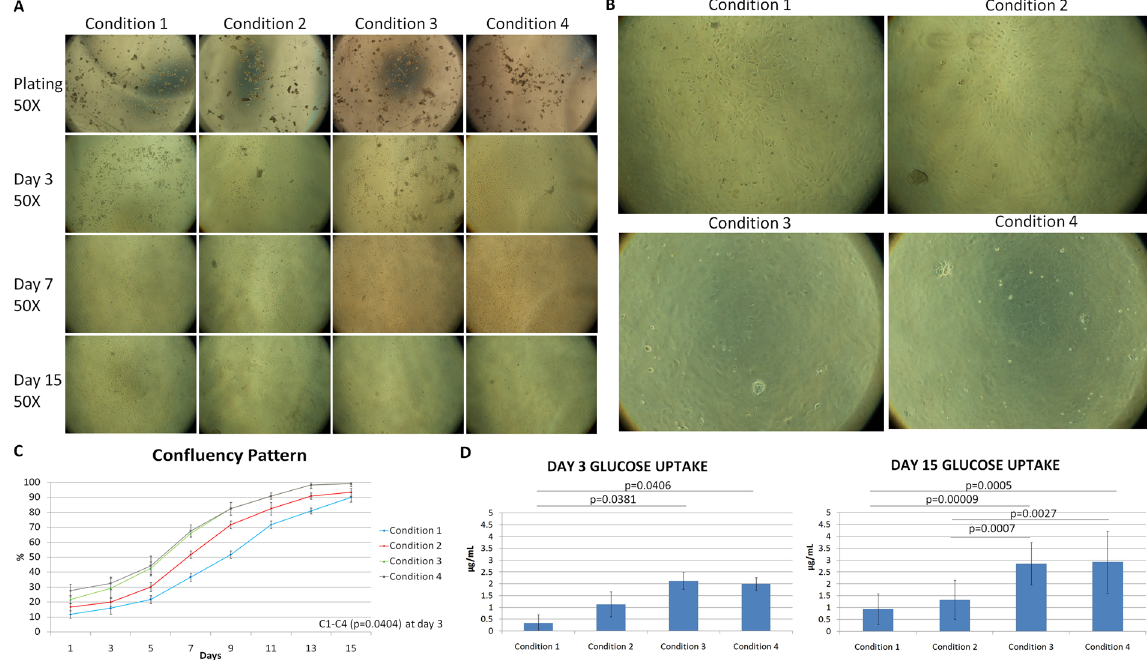
Figure 2. Morphological and glucose analysis. ( A ) It was observed that the cells attach firmly in C2, C3 and C4 and start proliferation within day 3. However, by day 7, C3 and C4 show a higher number of cells and growth